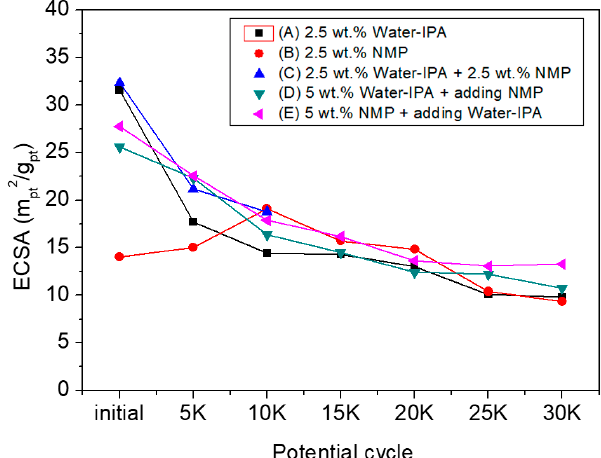
Figure 2. ECSA of MEAs prepared from the five dispersions at 0.6 V as a function of the number of potential cycles.